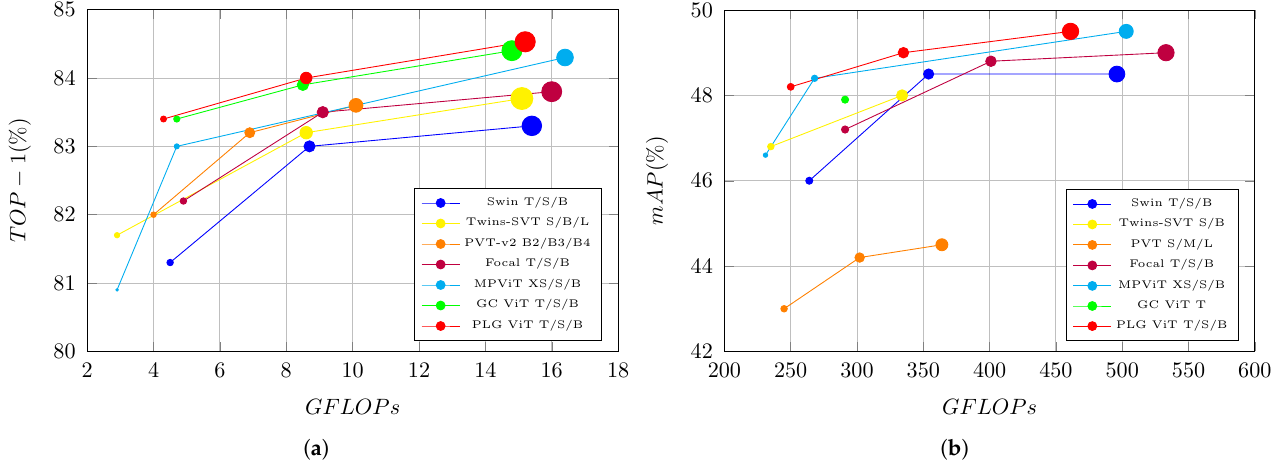
Figure 1. Comparison of PLG-ViT in terms of accuracy and efficiency with state-of-the-art meth- ods [12,13,15–17,19,20] on the benchmarks ImageNet [21] and COCO [22]. Each method is represented by a circle whose diameter is proportional to the number of parameters. Our PLG-ViT outperforms comparable methods in terms of accuracy with similar numbers of FLOPs and parameters on both benchmarks. ( a ) Classification on ImageNet [21]. ( b ) Object Detection on COCO